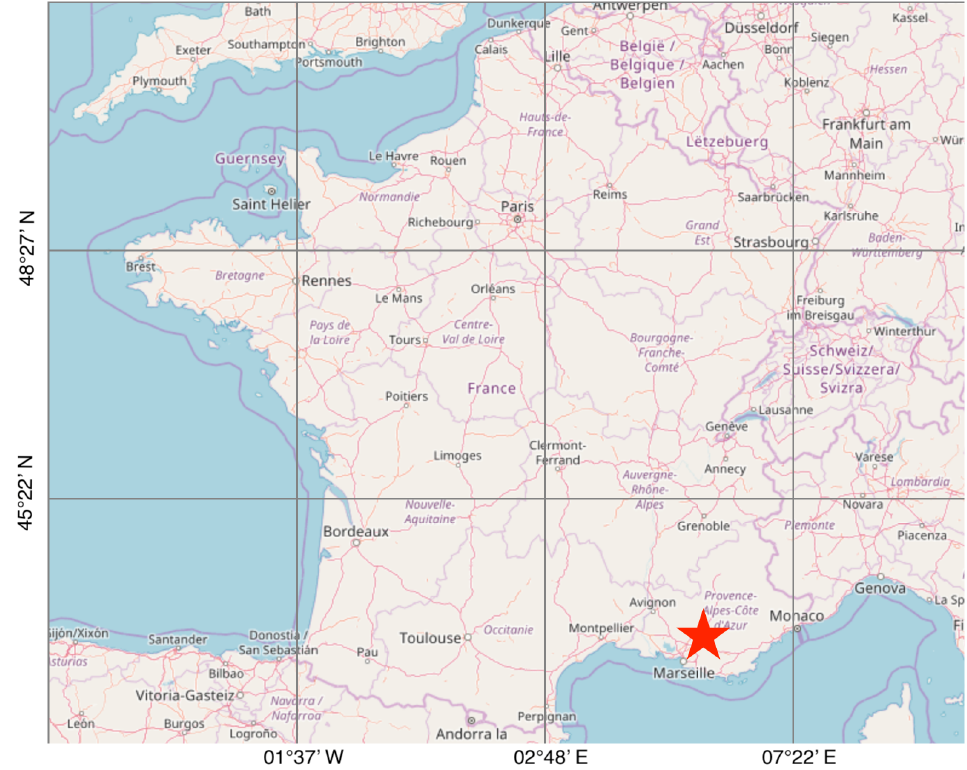
Figure 1. Map of France highlighting the Cadarache Valley experimental site (red star). © Open- StreetMap contributors